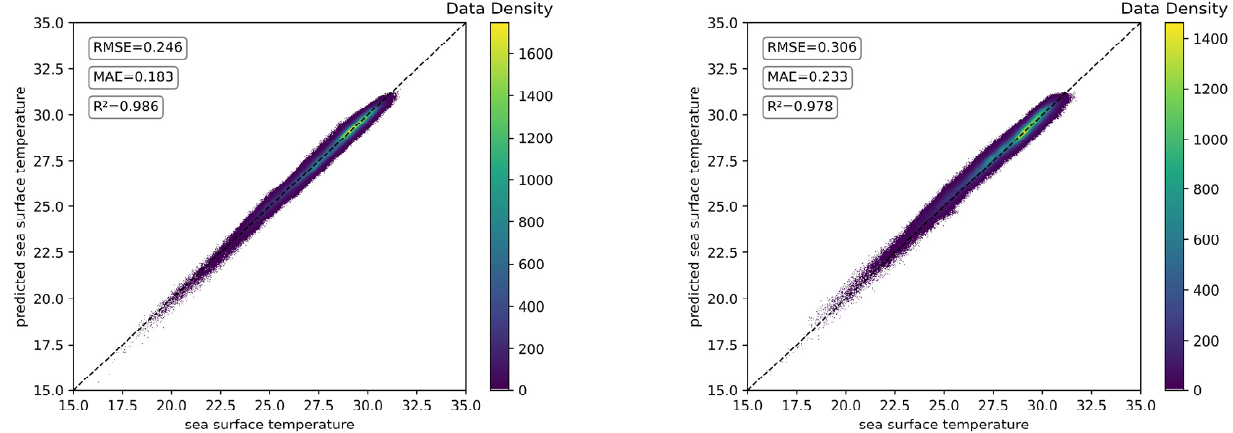
Figure 8. Comparison of SST prediction performance using ConvLSTM. On the left, the prediction length is set to 1, and on the right, it is set to 15.